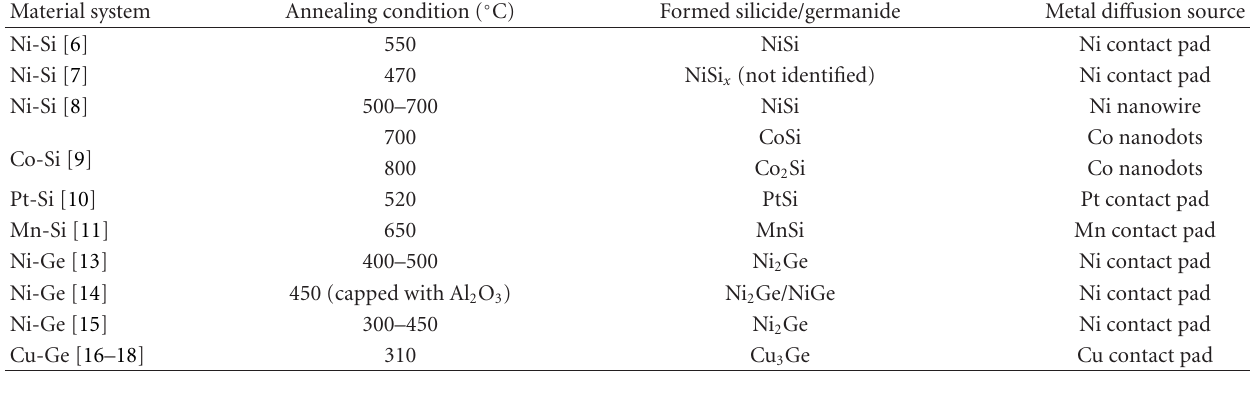
Table 1: Summary of Si and Ge nanowire heterostructures formed by solid-state reactions between a semiconductor nanowire and metal contacts.